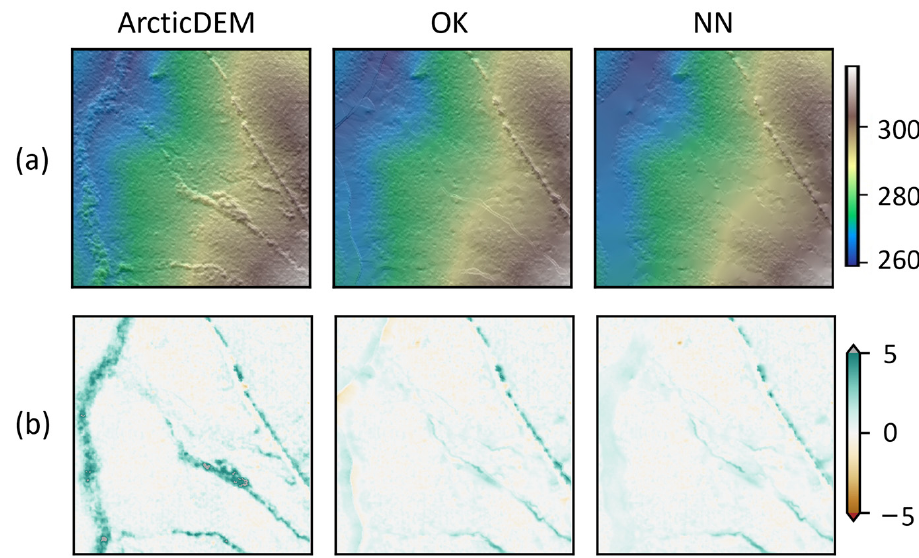
Figure 9. ArcticDEM and DTM interpolation at Site-3: ( a ) ArcticDEM, DTMs predicted by OK and